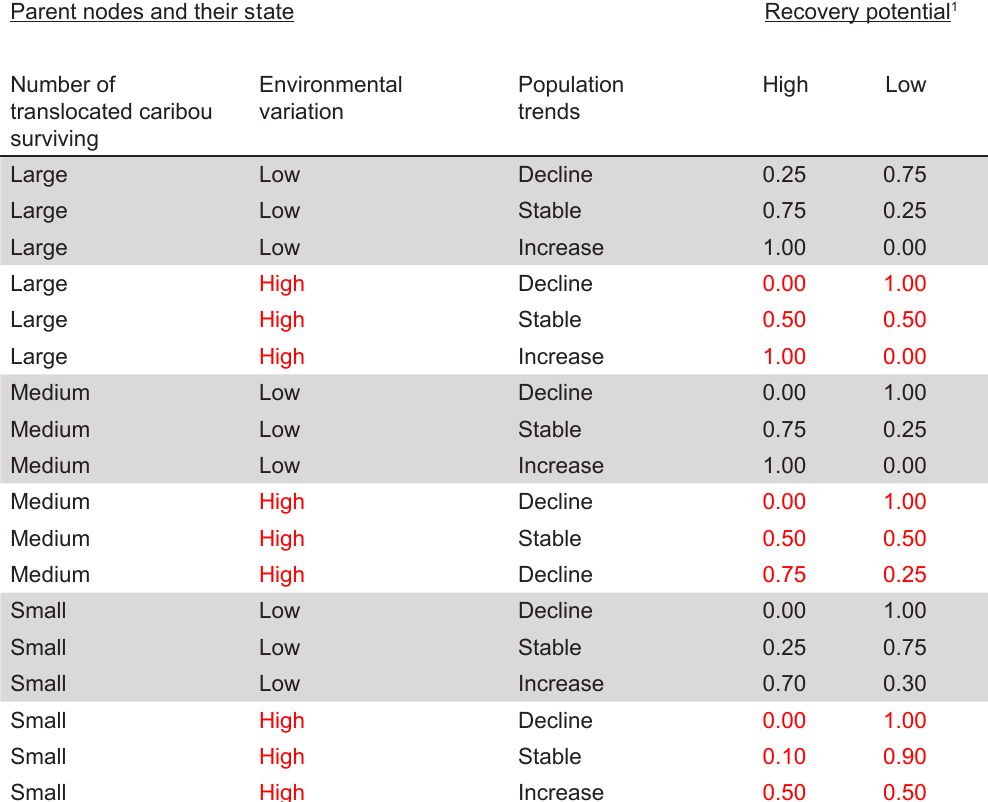
Table A1. Conditional probability table for node recovery potential. Parent nodes and their